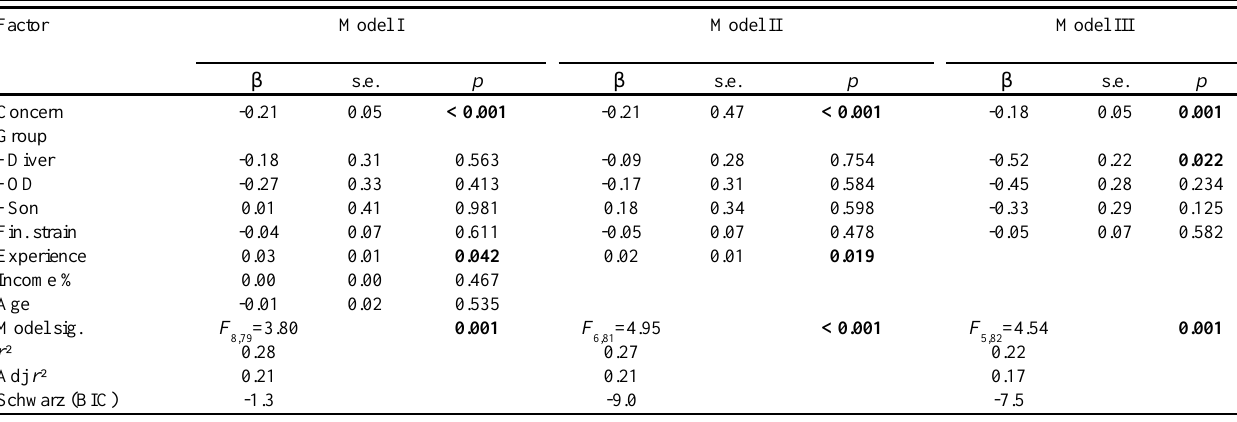
Table 4 . Comparison of selected regression models explaining respondents’ suggested values for the total allowable commercial catch (TACC). Figures in bold highlight significant relationships ( a = 0.05). OD = owner diver.